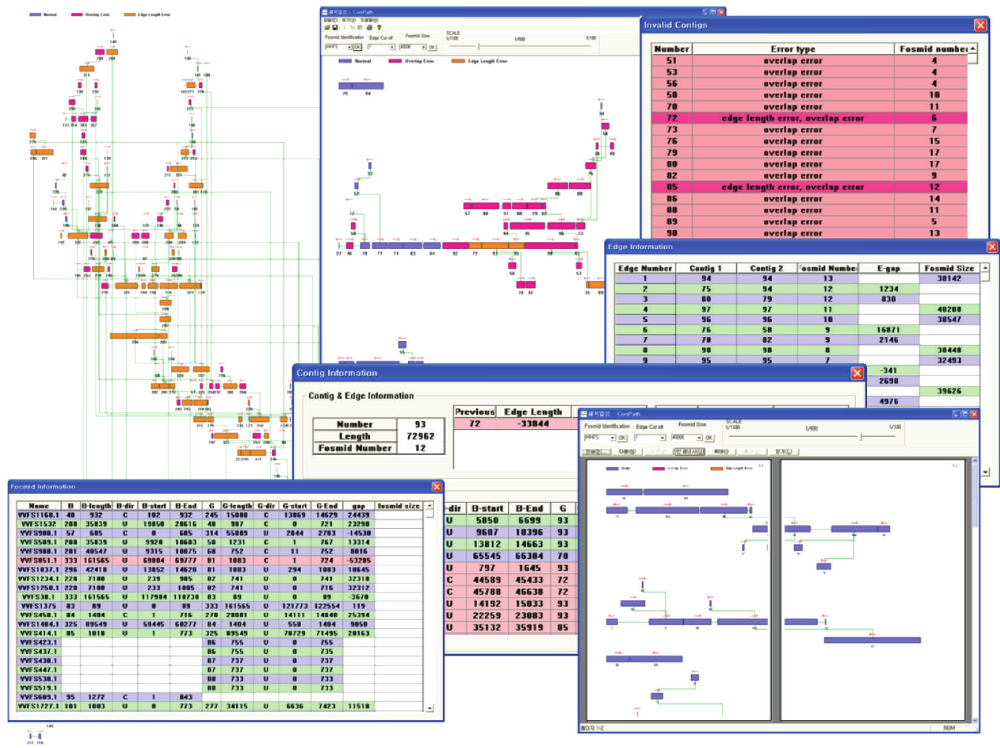
Figure 4: A set of snapshots of ConPath . ConPath provides a set of useful information, “mate-pair information”, “edge information”, “contig path”, and “invalid contigs” by checking for the 4 types of